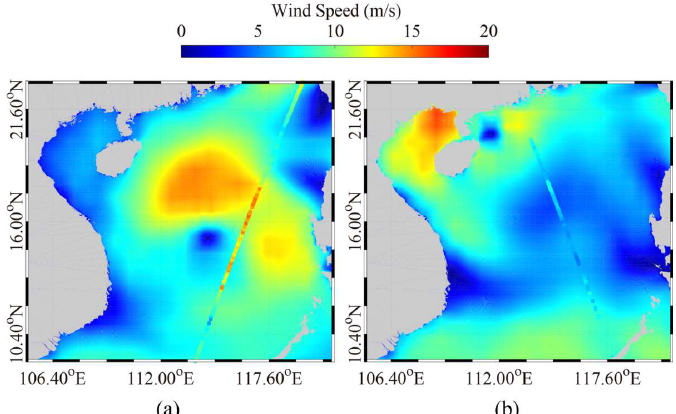
Figure 2. The maps of the European Centre for Medium-Range Weather Forecasts (ECMWF) winds overlaid with footprints of satellite altimeter Jason-2. ( a ) wind speed map on 13 September 2017 at 12:00 p.m. UTC during Typhoon Doksuri; and ( b ) wind speed map on 15 October 2017 at 6:00 p.m. UTC during Typhoon Khanu.